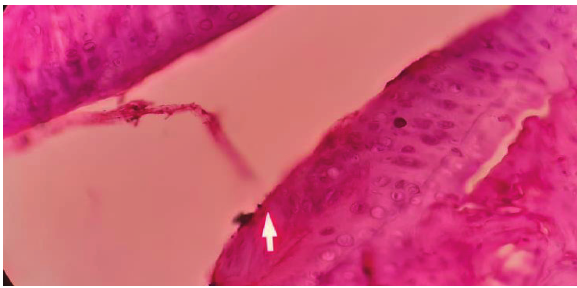
Fig-4: Photomicrograph of ankle joint of a rat of Group C Treatment with telmisartan for two weeks decreased the arthrogram score, TLC and also showed improvement on histological examination. The intergroup comparison of the three groups of all the parameters depicted a statistically significant p value ˂ 0.001 as shown in Table -1.